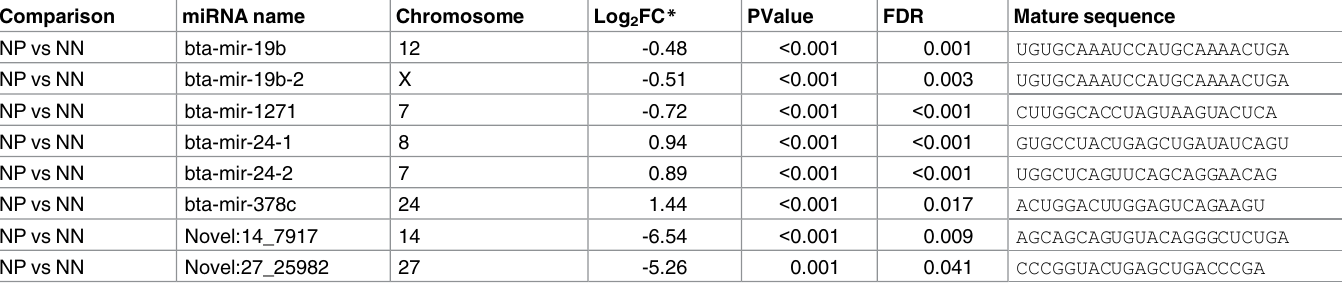
Table 2. Differentially expressed miRNAs in NP vs NN comparison. Comparison